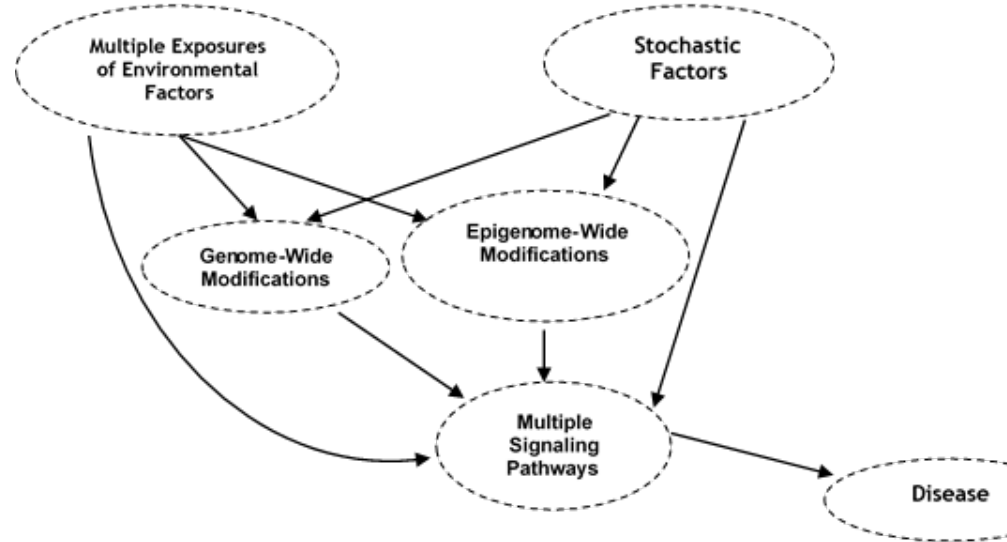
Figure 2. Scheme showing how eDNA record of genome- and epigenome-wide modifications of exposure to environmental stressors that may increase susceptibility of chronic diseases.